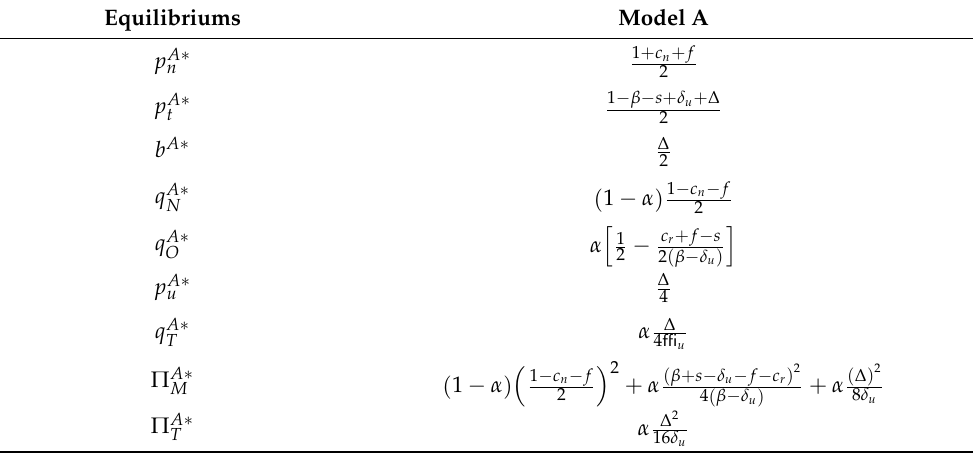
Table 6. Optimal solution of Model A closed-loop supply